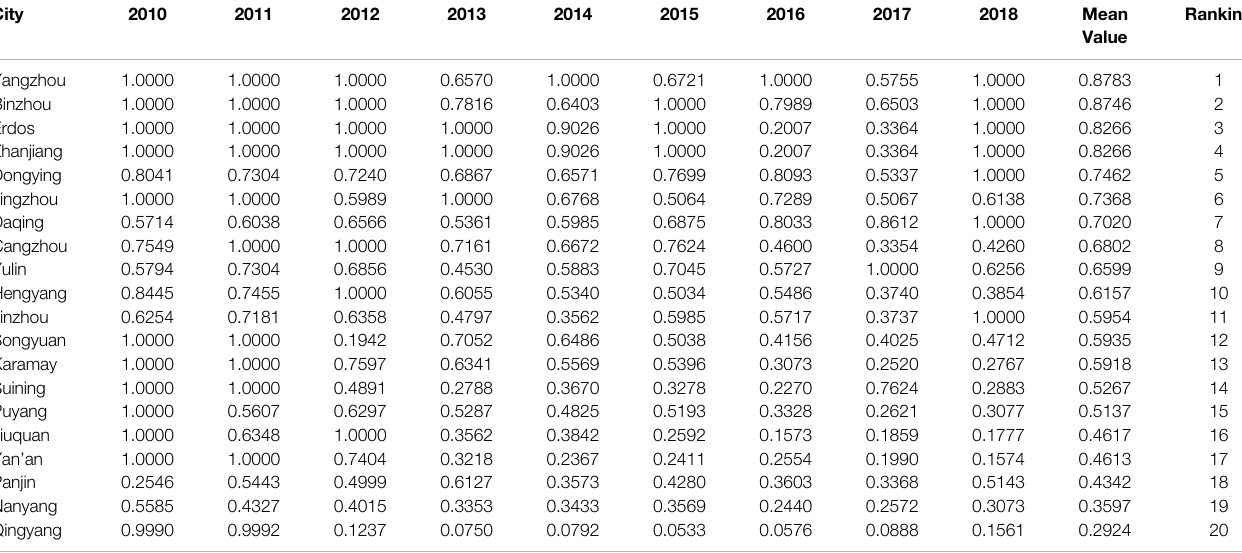
TABLE 3 | Static ef fi ciency evaluation results of green growth of Oil and gas resource-based cities.